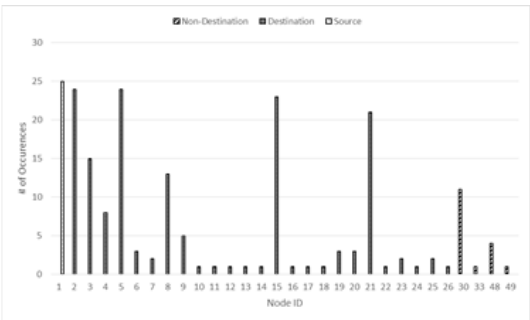
Fig. 18. Number of Paths Each Node Participates in for a Multicast Tree with 50 Nodes and 25 Destinations